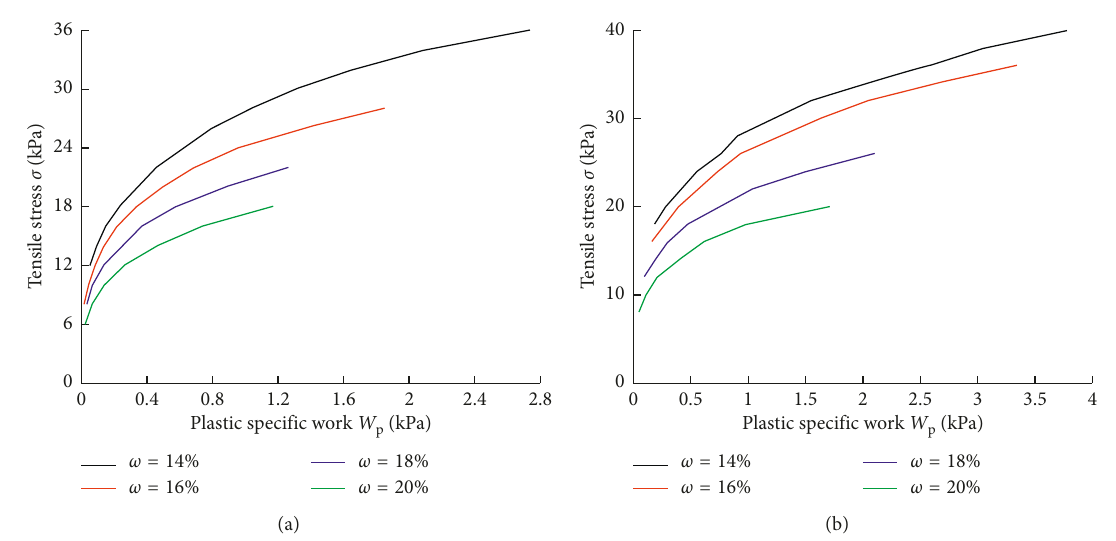
Figure 6: Plastic constitutive relation σ � F ( W